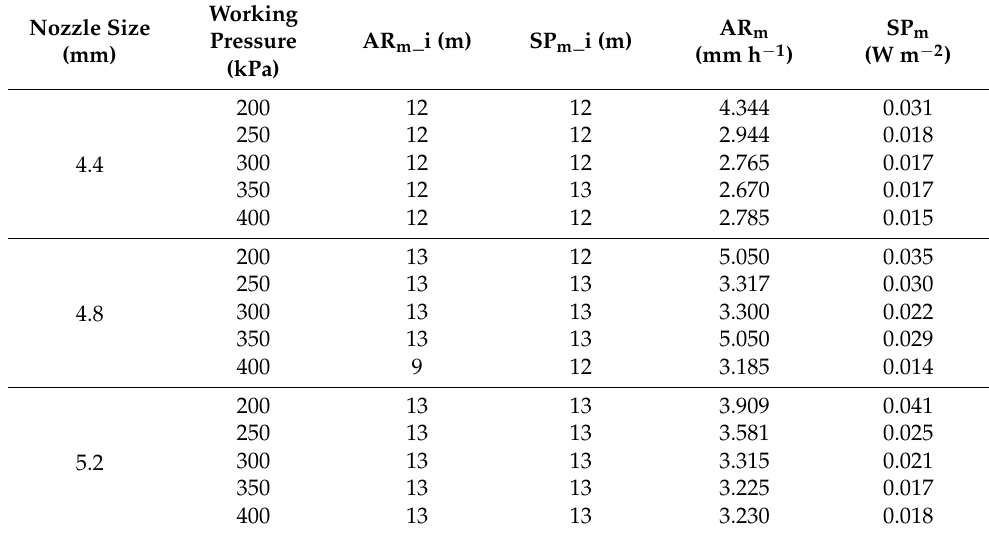
Table 3. Distance of peak points and peak values of SP and AR from the